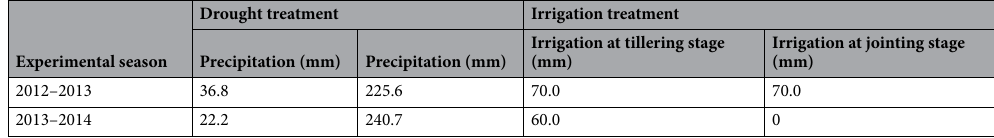
Table 3. Total precipitation during the growth period of 2012–2014 (mm) and the irrigation supplement in the irrigation treatment (mm).